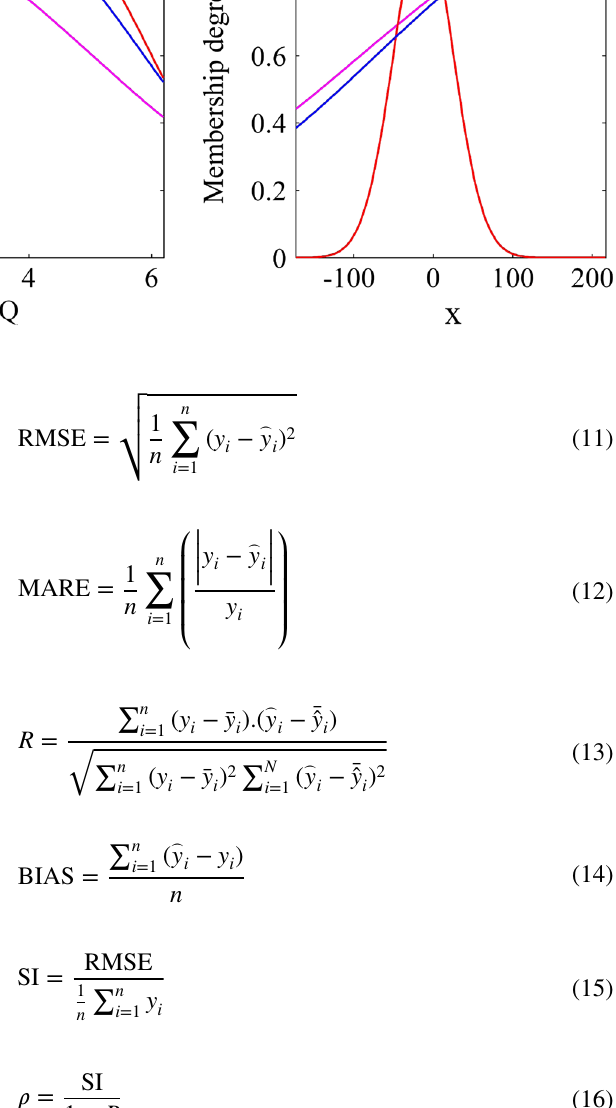
Fig. 6 Optimal membership function form of the trade-off design point